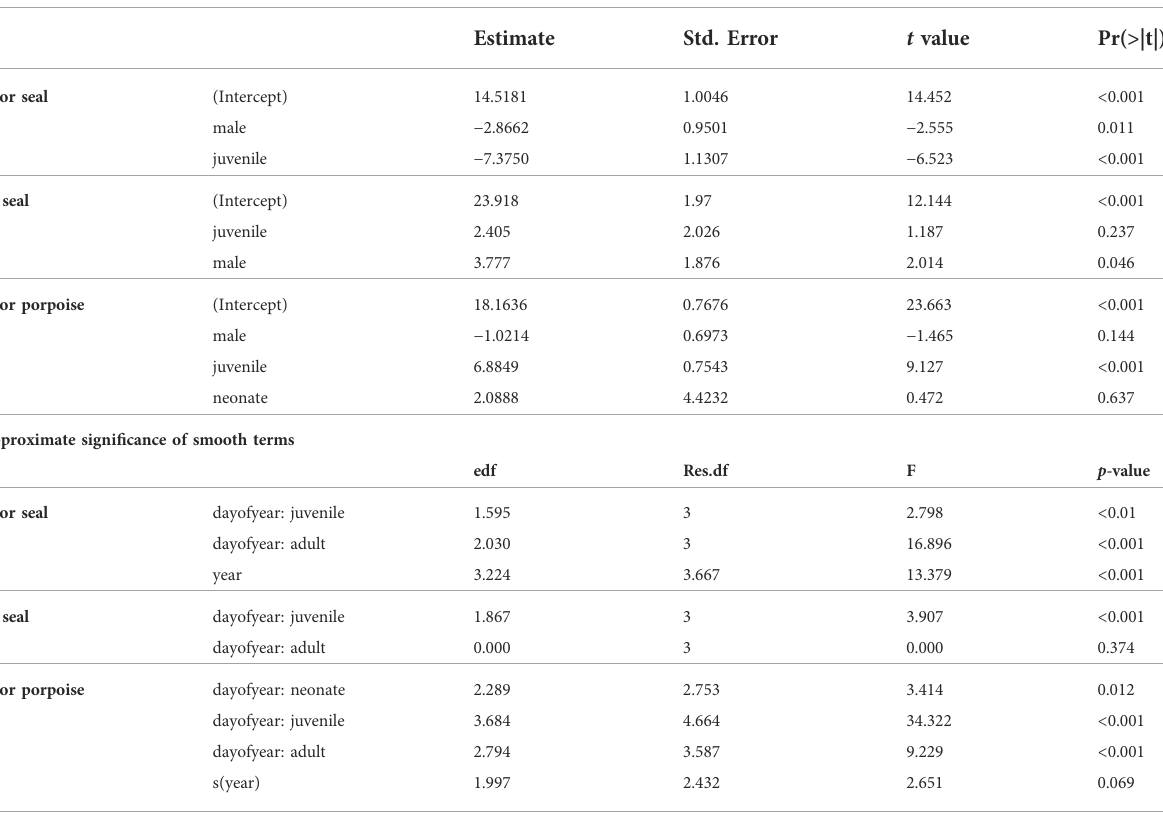
TABLE 3 GAMs of blubber thickness as related to day of the year conditional on 1) harbor seals — age group juveniles (present and previous years offspring),adultsandthedevelopmentoverthestudyperiod;2)greyseals-agegroupjuveniles(presentandpreviousyearsoffspring)andadults; 3) harbor porpoises -age group neonates,juvenilesand adults. Moreover, the parametric terms ofsex and age group, showing the signi fi cant effects of the fi xed effects, are given (estimates, SE, t -values, and p -values); as well as the approximate signi fi cance of the smooth terms (the